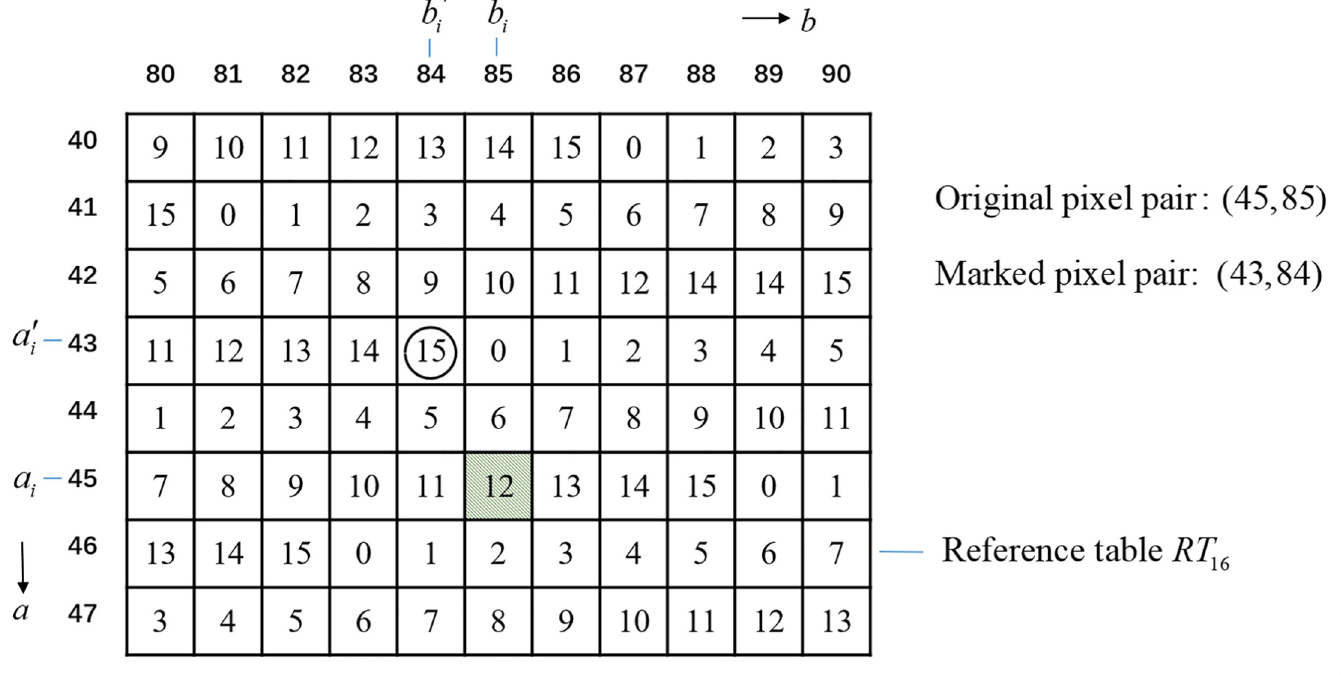
PLOS ONE | https://doi.org/10.1371/journal.pone.0230997 April 16,